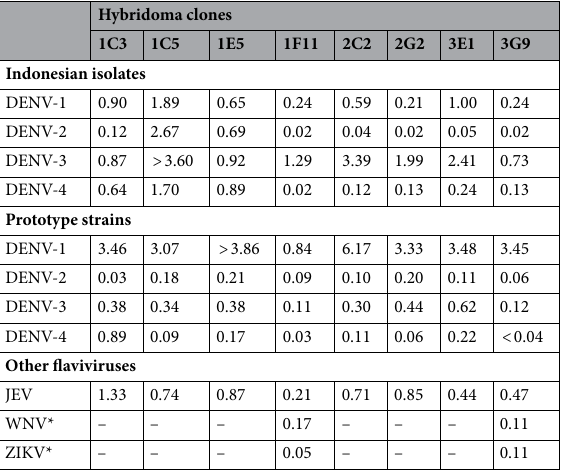
Table 1. The NT 50 values of the HuMAbs. Average of two independent neutralization tests is shown (μg/ml). *The WNV and ZIKV results were determined using SRIPs containing the prM-E genes of each